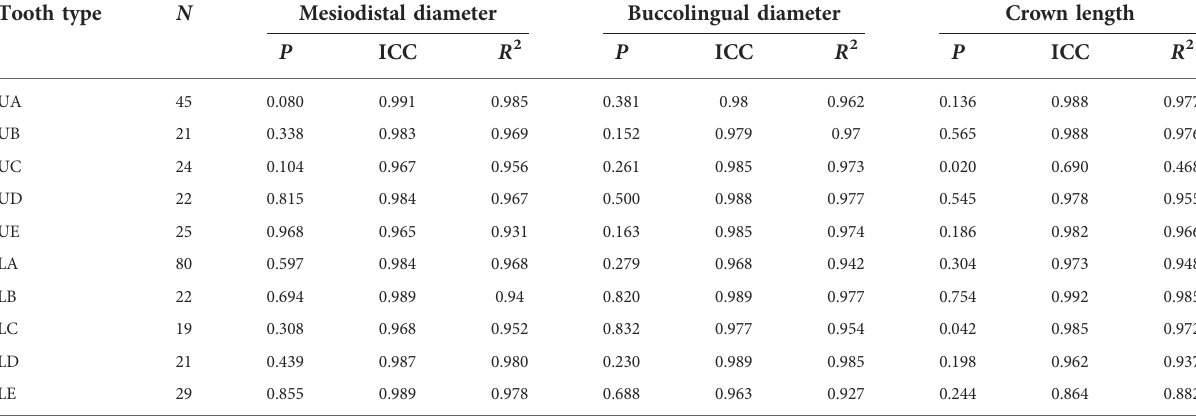
TABLE 1 Results of paired t -test, consistency analysis, and regression analysis for mesiodistal diameter buccolingual diameter and crown length of 308 extracted primary teeth by manual and digital measurement. Tooth